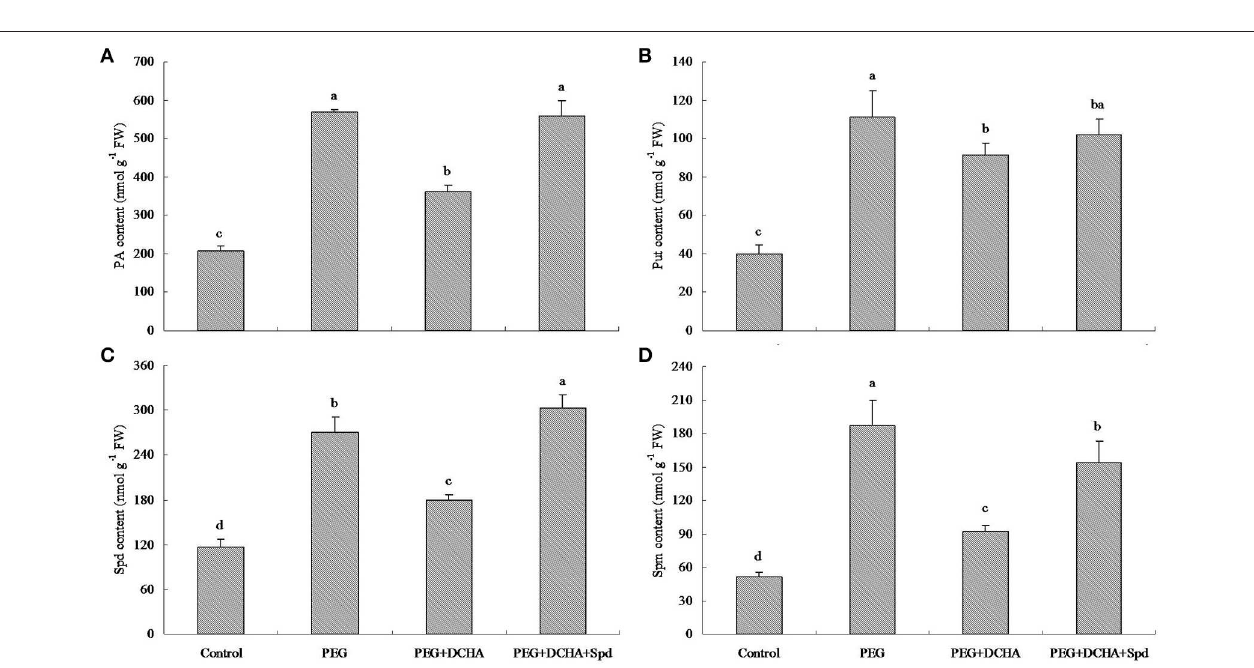
FIGURE 3 | Effects of spermidine (Spd) and inhibitor (DCHA) of aminopropyl transferase on PEG 6000-induced polyamine (PA) (A), putrescine (Put) (B), spermidine (Spd) (C), and spermine (Spm) accumulation (D) in leaves. The detached leaves of white clover were pre-treated with distilled water for 1h to eliminate wound stress and then treated for 1h as follows: 1, distilled water (control); 2, 15% PEG; 3, 15% PEG + 100 µ M dicyclohexylamine (DCHA); 4, 15% PEG + 100 µ M DCHA + 20 µ M Spd. Means of four independent samples are presented. Bars represent standard errors. The same letter above columns indicates no significant difference (LSD) at P <